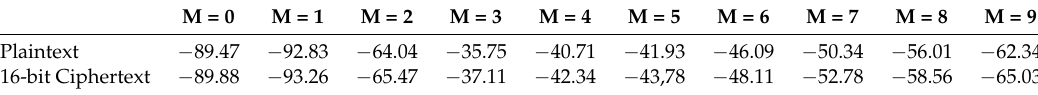
Comparison of error between plaintext and ciphertext evidence. Table 3.